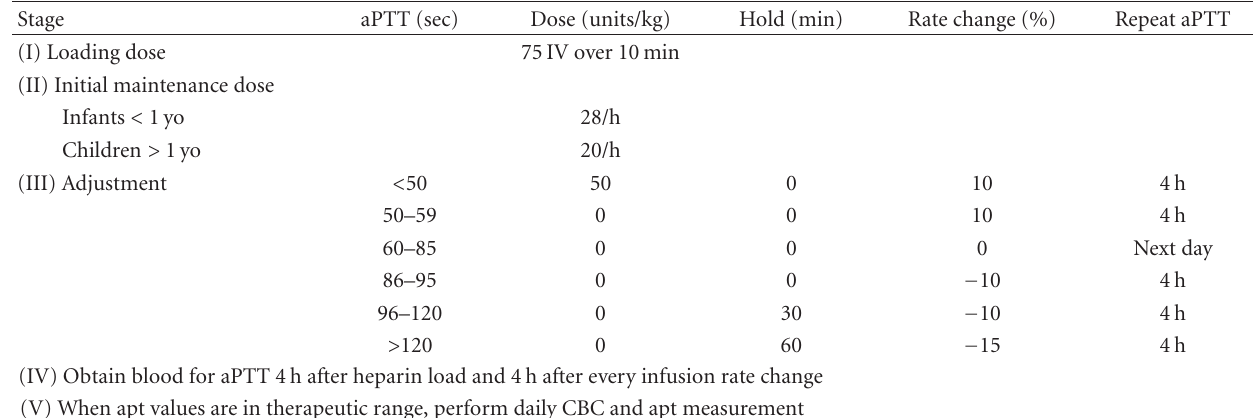
Table 4: Protocol for systemic heparin administration and adjustment in